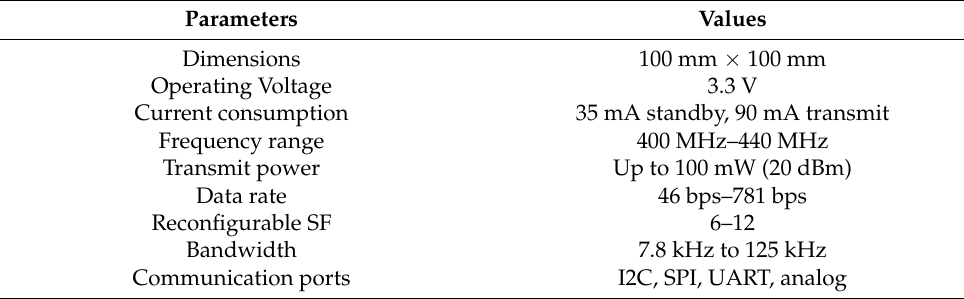
Table 3. Specifications of the fixed GST